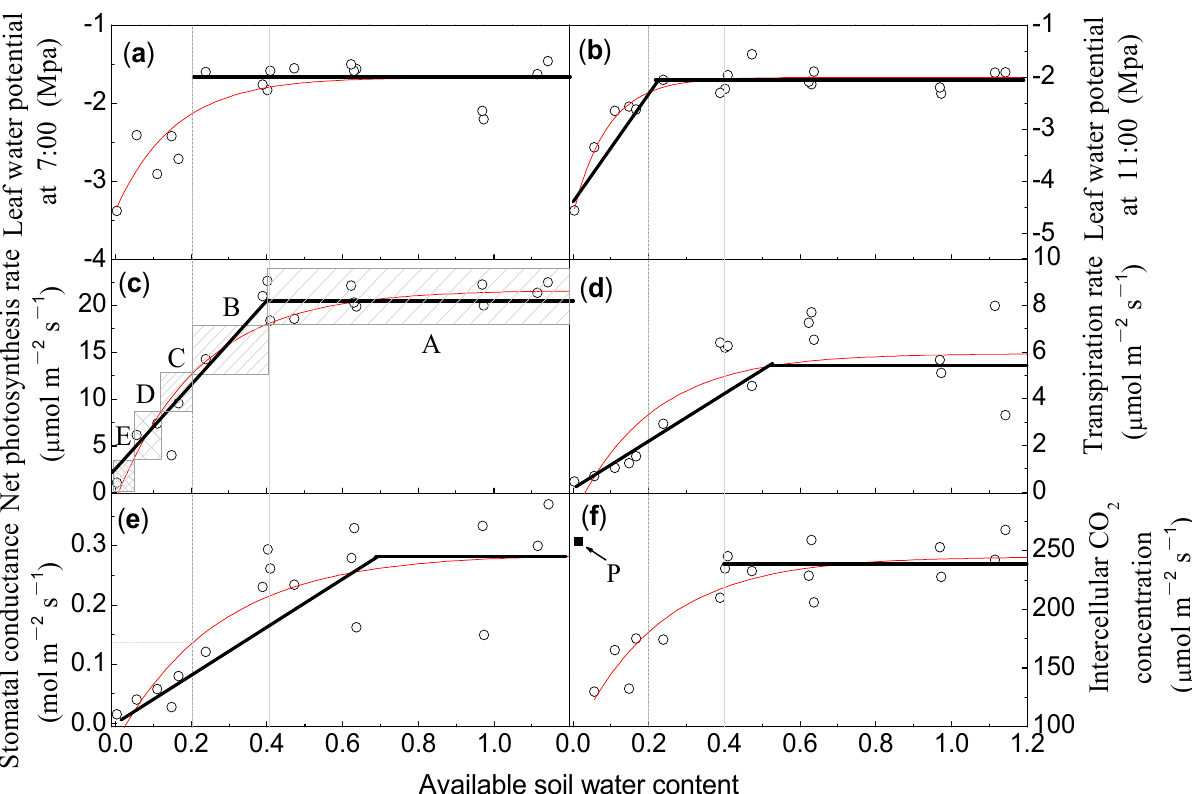
Figure 1. Relationships between available soil water content and physiological indices for spring wheat, including ( a ) leaf water potential at 7:00, ( b ) leaf water potential at 11:00, ( c ) net photosynthetic rate, ( d ) transpiration rate, ( e ) stomatal conductance and ( f ) intercellular CO 2 concentration. Note: Red lines indicate the fitted curves of response of physiological indices to soil water. Black bold lines indicate trend of change for physiological indices. Vertical solid line and vertical dotted line indicate the available soil water content for the first threshold and second threshold respectively based on net photosynthesis rate of spring wheat; A, B, C, D and E indicates the different drought stages based on response of photosynthetic features to available soil water content for spring wheat during jointing stage.